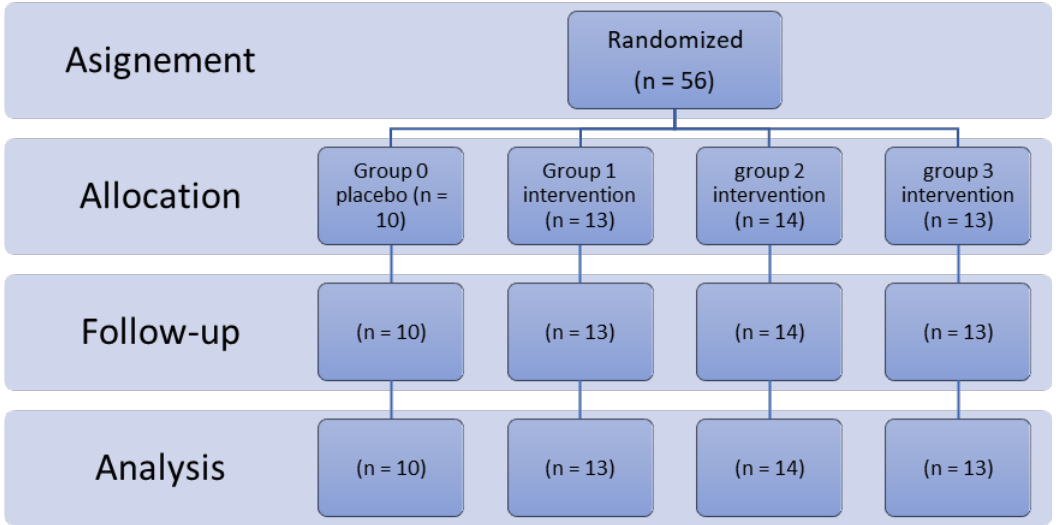
Figure 1. Flow diagram of the study.